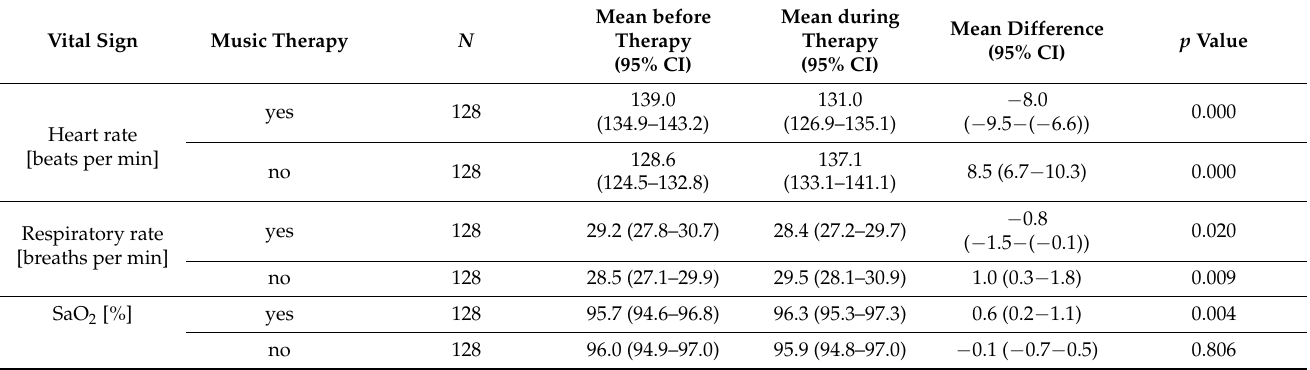
Table 2. Heart rate, respiratory rate and oxygen saturation before and during physical therapy sessions with and without music